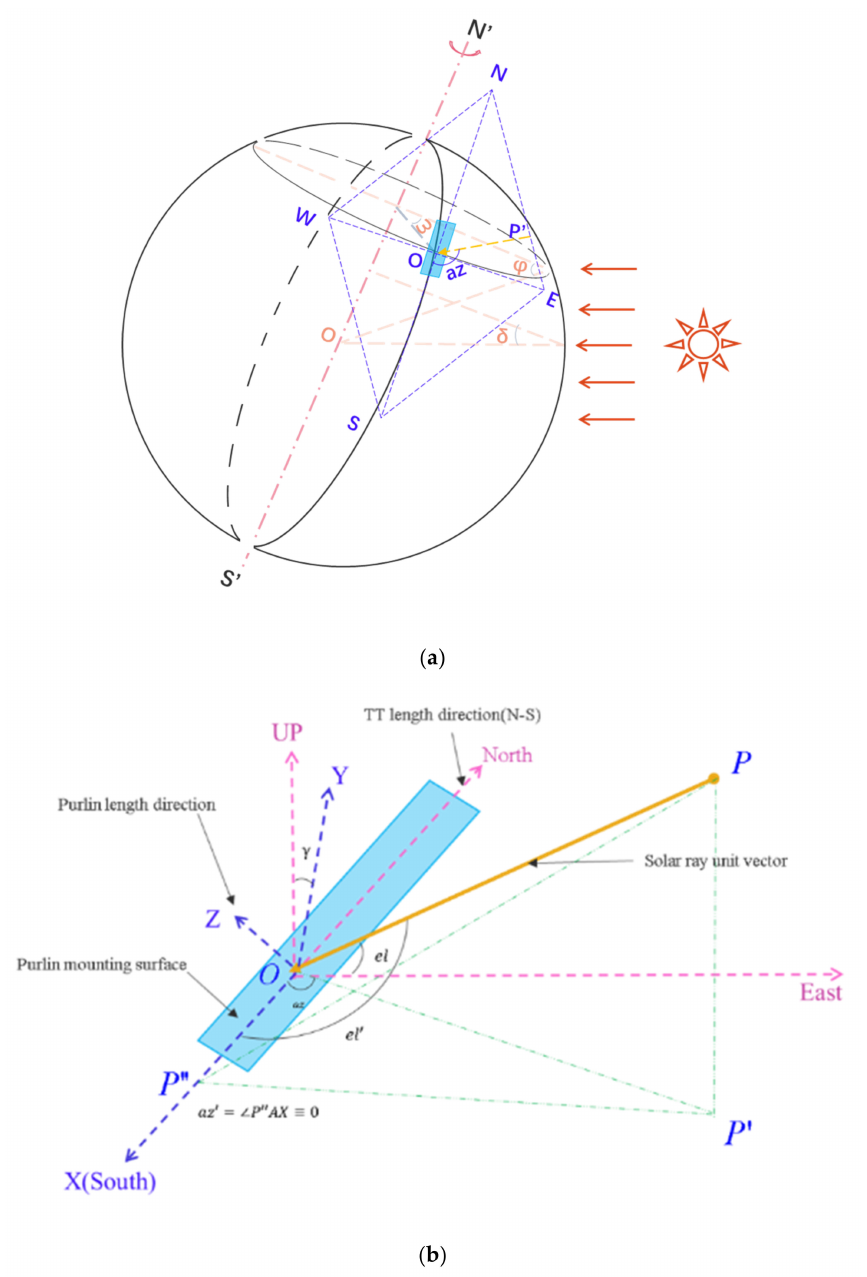
Figure 5. ( a ). Schematic diagram of latitude ϕ , hour angle ω , declination angle δ , azimuth angle az at any position O on the Earth’s surface. ( b ). Local coordinate system OXYZ and geocentric celestial coordinate